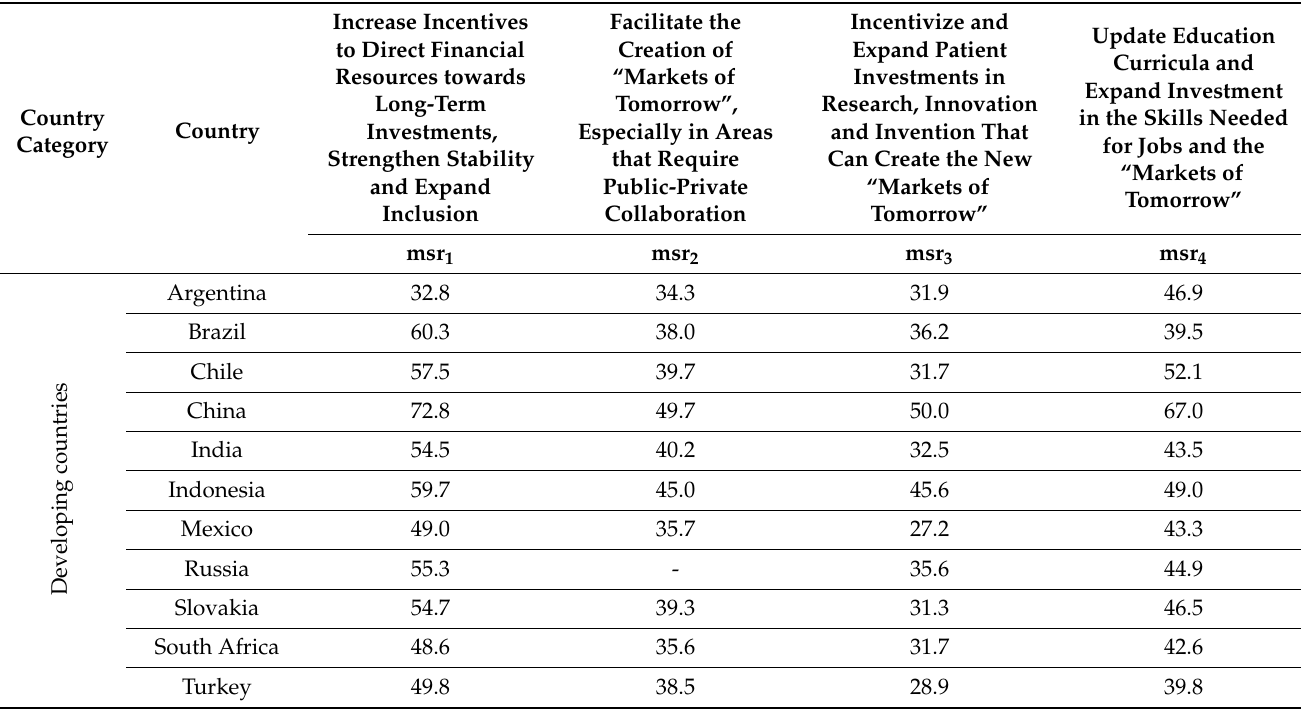
Table 2. Specific factors of financing of sustainable development in emerging economies of the sample in 2021 (as a result of 2020), points